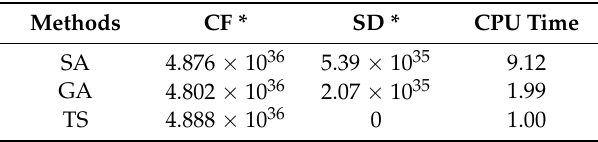
Table 1. Comparative analysis of